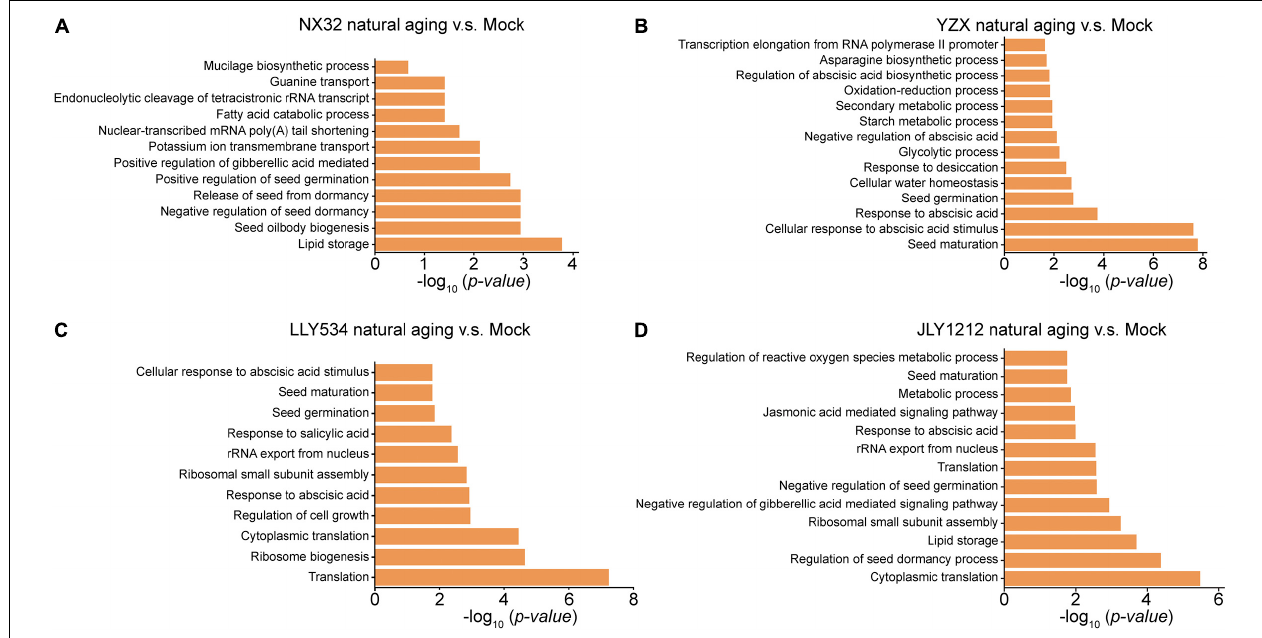
FIGURE 5 | Gene Ontology (GO) enrichment of genes with significant expression changes after natural aging treatment compared with mock treatment in four rice varieties. (A–D) GO terms of NX32 (A) , YZX (B) , LLY534 (C) and JLY1212 (D) after natural aging. The y-axis represents the functional subcategory, and the x-axis represents the value of the − log 10 ( p -value), which indicates the significance